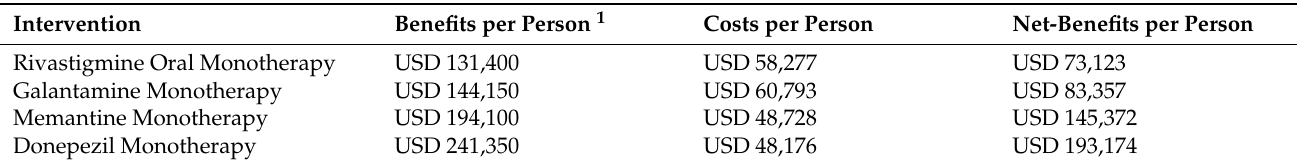
Table 4. Net Benefits of Various Dementia FDA-approved medicine